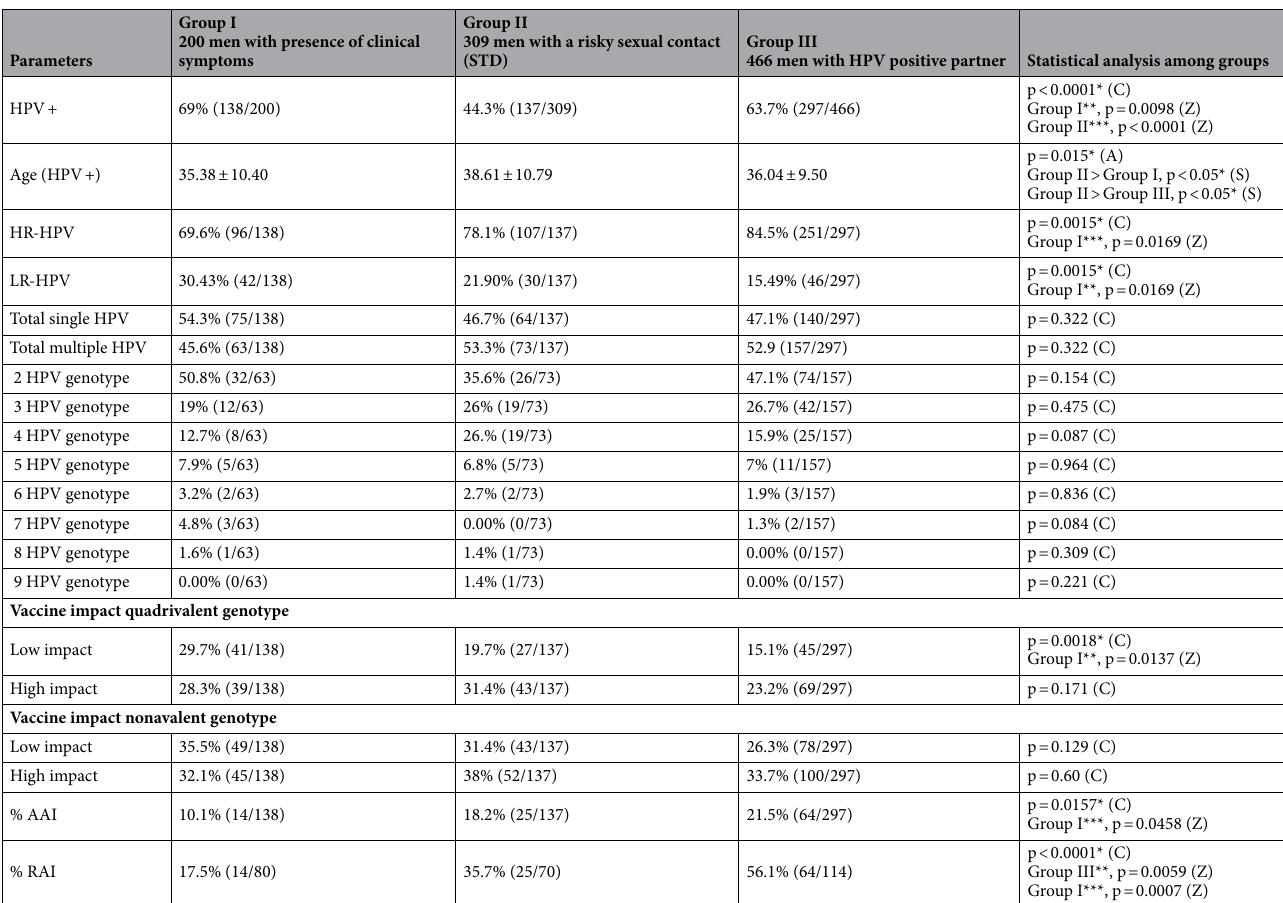
Table 2. Characteristics of pathologic patients grouped for disease. AAI absolute additional impact, RAI relative additional impact, clinical symptoms condiloma, atypical lesions. *Significant test, **most frequent, ***less frequent; C = multiple comparison χ 2 test; Z = Z-test; A = one way Anova test; S = Scheffé test for pairwise comparisons, post hoc Anova test.